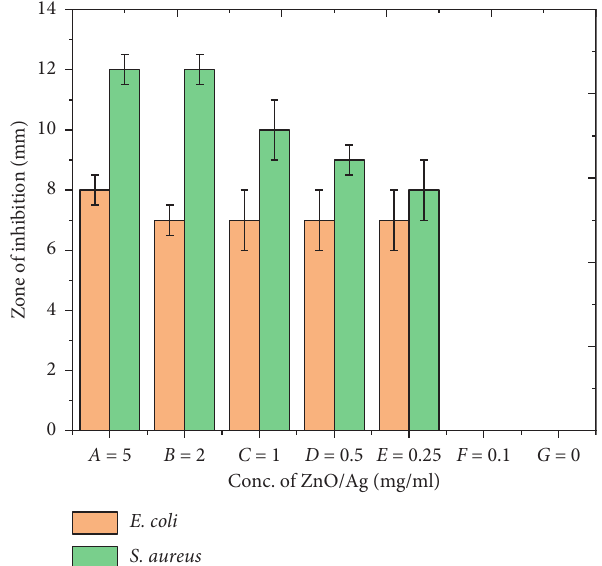
Figure 16: A histogram showing the activity of ZnO/Ag nano- composite against E . coli and S . aureus . A � 5mg/ml, B � 2mg/ml, C � 1mg/ml, D � 0.5mg/ml, E � 0.25mg/ml, F � 0.1mg/ml, and G �